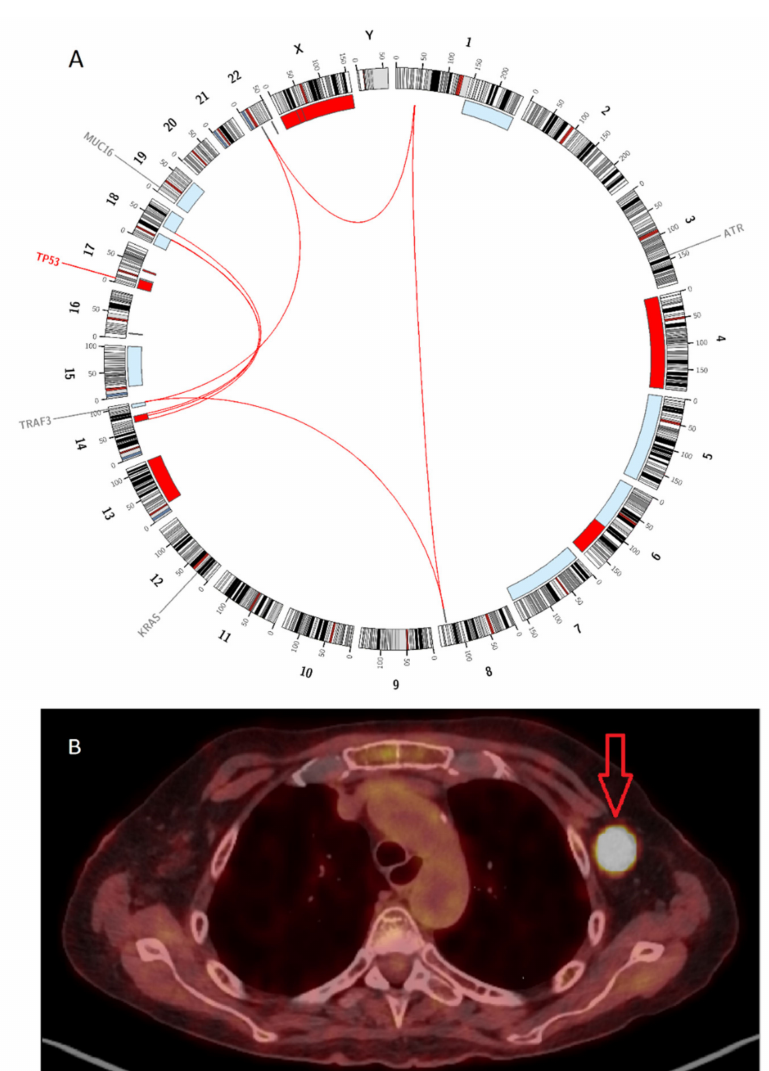
Figure 4. Whole-genome sequencing (WGS) and 18F-FDG PET / CT in the patient with biallelic TP53 alteration (No. 5 in Table 3): ( A ) Circos plot demonstrated data of WGS, including copy number variations (CNV), structural variations (SV), and single nucleotide variations (SNV), at the last relapse. Gains and losses of > 1 Mb are shown in blue and red, respectively. Interchromosomal reciprocal translocations with variant allele frequency (vaf) > 0.1 are displayed by red lines inside the circle. Gene mutations ( TP53 ) and variants ( ATR , KRAS , TRAF3, and MUC16 ) are marked in red and grey, respectively. ( B ) True extramedullary disease (axillary lymph node) with excessive FDG uptake, as shown on 18F-FDG PET / CT scans. Biallelic TP53 alteration might lead to aggressive tumor growth, e.g., development of extramedullary disease (EMD) and excessive FDG